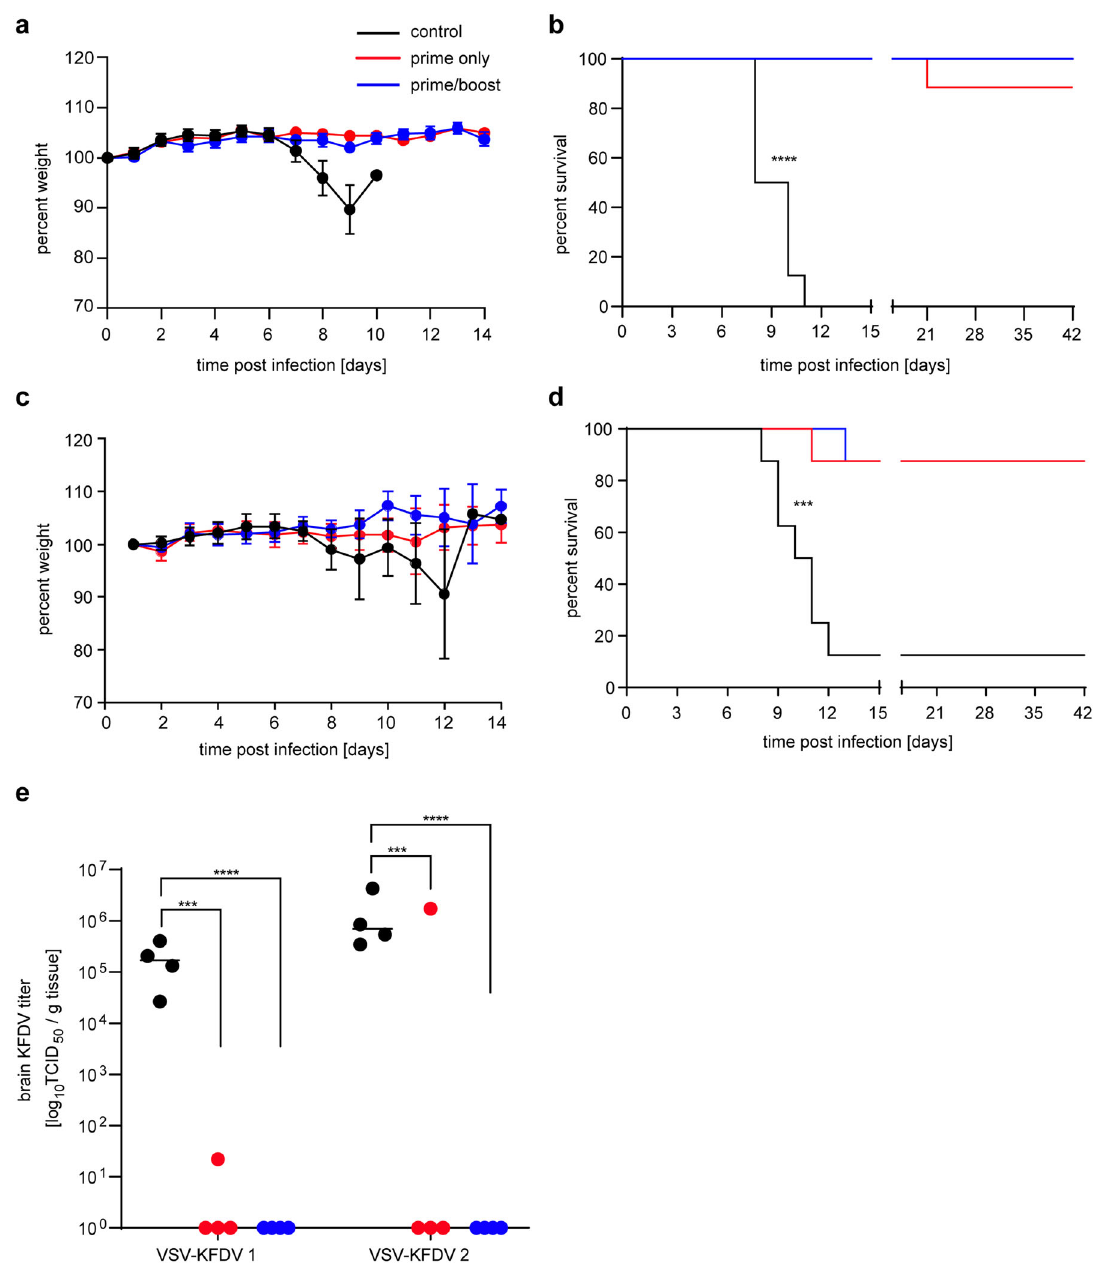
Fig. 4 Ef fi cacy of VSV-KFDV vaccines against lethal KFDV challenge. Groups of 12 BALB/c mice were injected intraperitoneally with 10 4 PFU VSV-KFDV at day-56 and -28 (prime-boost group) and at day-28 (prime only). The animals were challenged with 1000LD 50 (10 PFU) of KFDV at day 0 and monitored over a period of 42 days. Control animals were immunized with 10 4 PFU of VSV-EBOV vaccine at the same time points and challenged the same way. a Weight curve VSV-KFDV1. b Survival curve VSV-KFDV1. c Weight curve VSV-KFDV2. d Survival curve